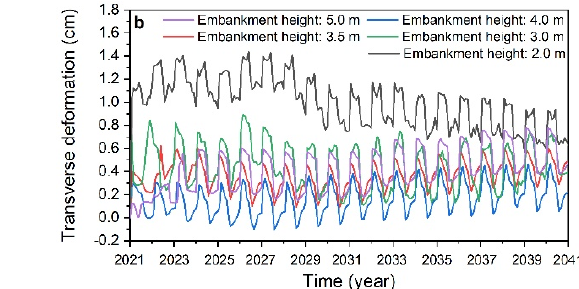
Figure 11. Curves of the variation in vertical deformation difference (uneven settlement) between the shoulders and the road centerlines of different structures.